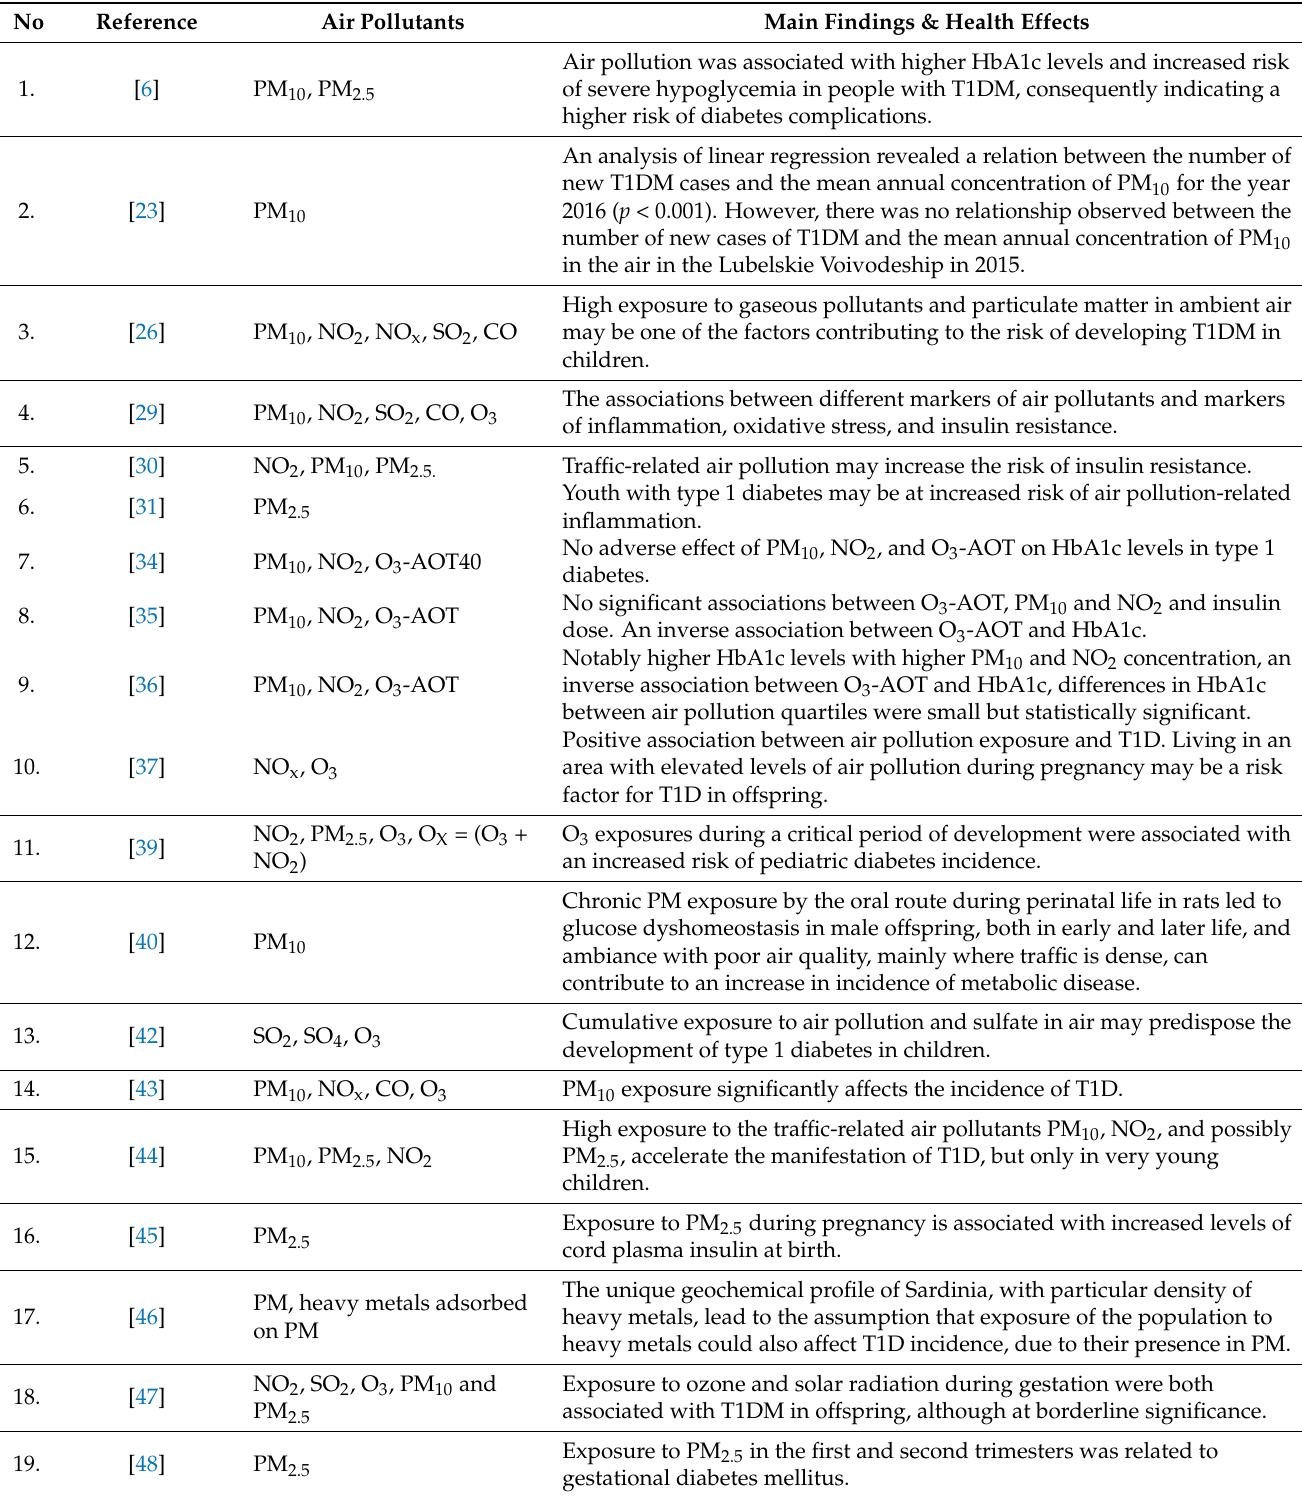
Table 1. Air pollution and type 1